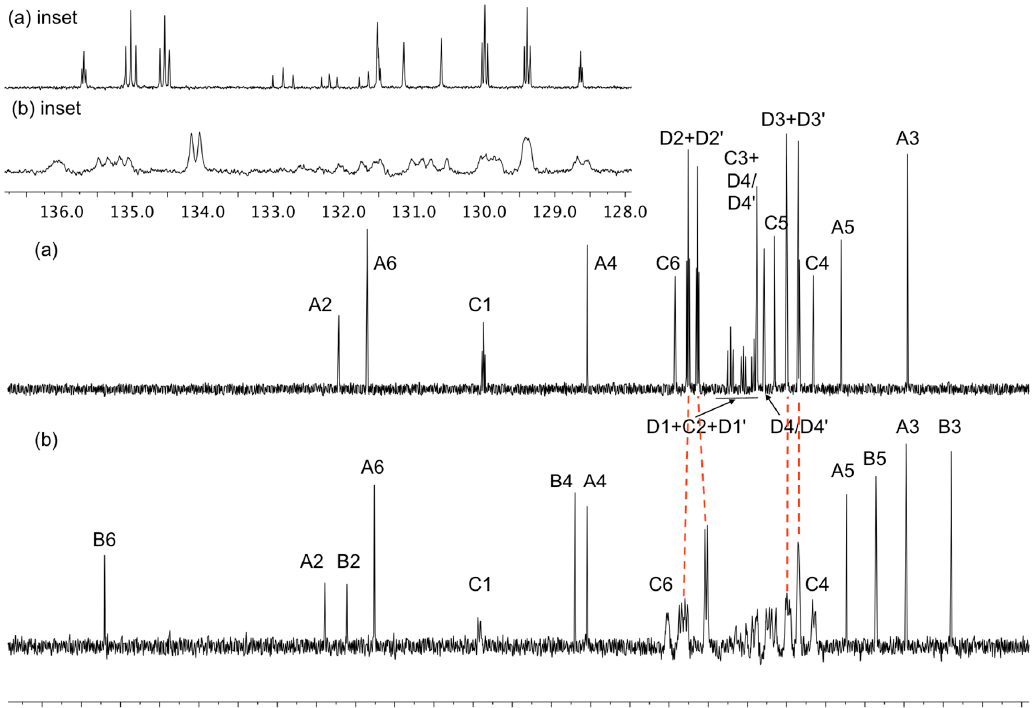
Figure 4. 13 C{ 1 H} NMR spectra (126 MHz, acetone- d 6 , 298 K) of ( a ) [Cu(BIPHEP)(bpy)][PF 6 ] and ( b ) [Cu(BIPHEP)(6-Etbpy)][PF 6 ], with expansions of the regions δ 137–128 ppm (signals from C C6 to C C4 ), shown in the insets at the top-left. Scale: δ /ppm.